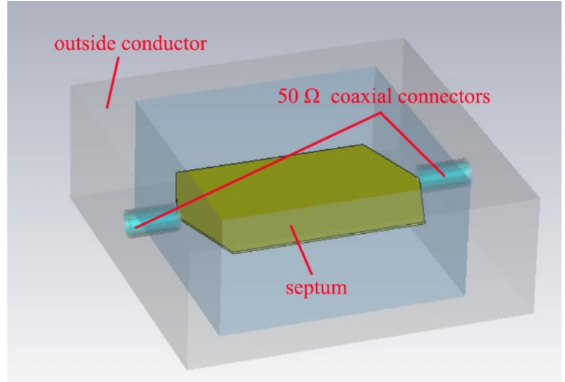
Figure 4. The model of the cell established in